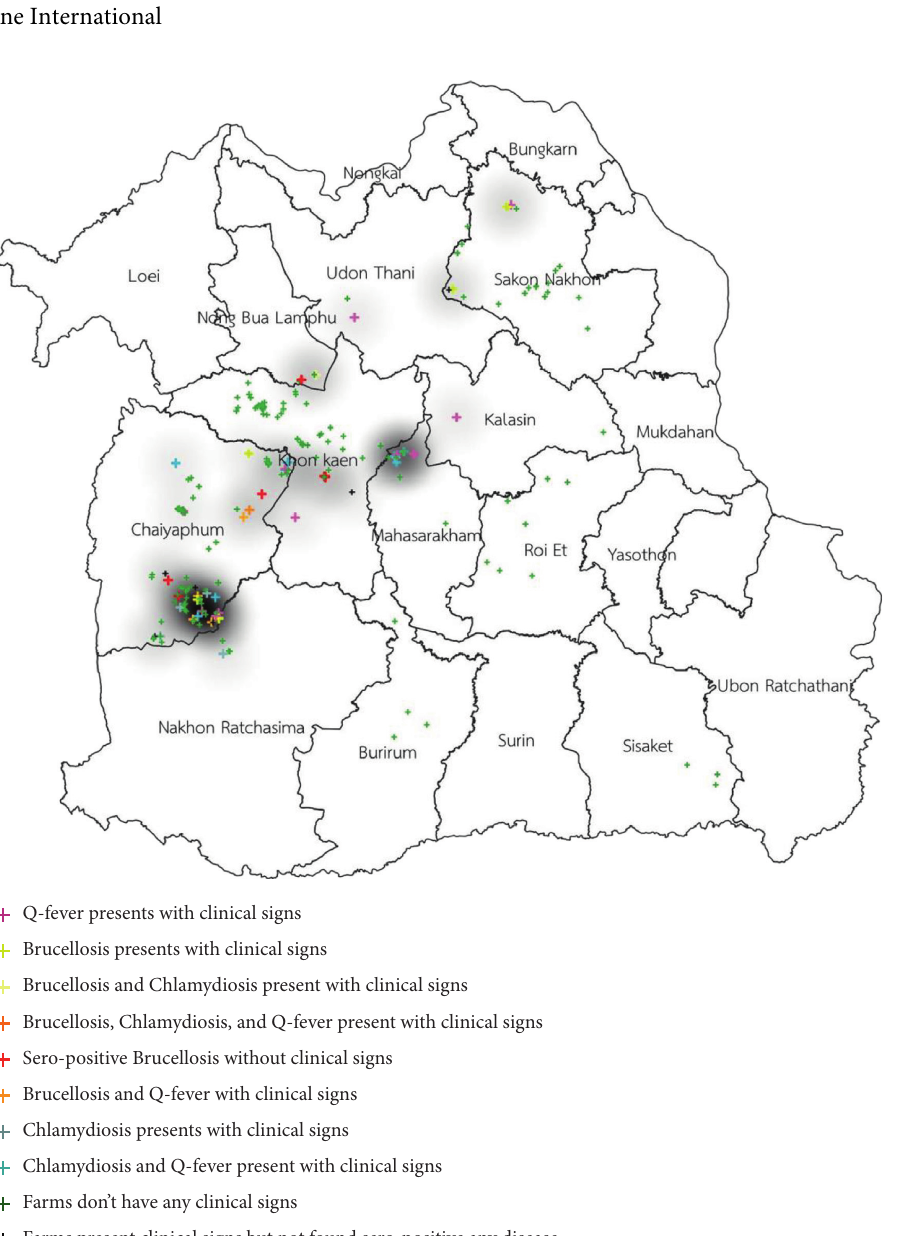
Figure 1: Distribution of clinical cases of brucellosis, chlamydiosis, and Q fever infection in smallholder meat goat herds in northeastern